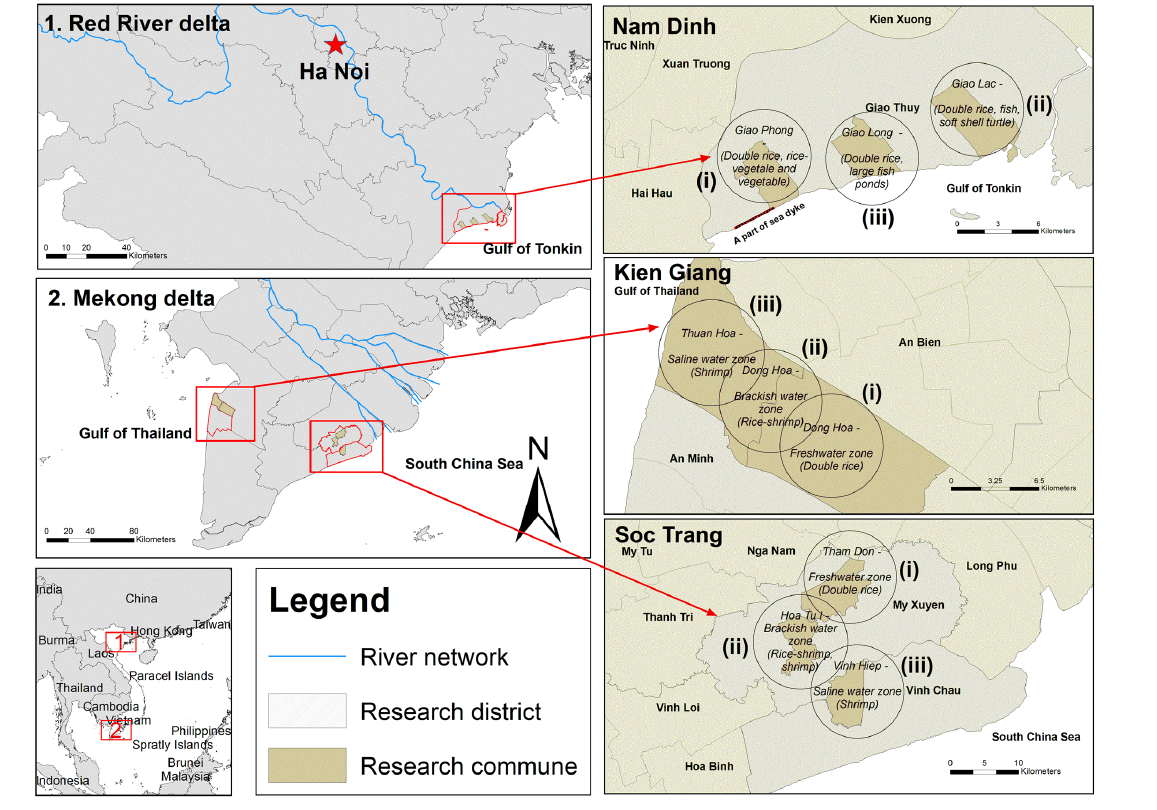
Fig. 1 . Research sites in the Red River (1) and Mekong (2) deltas with main farming systems indicated in